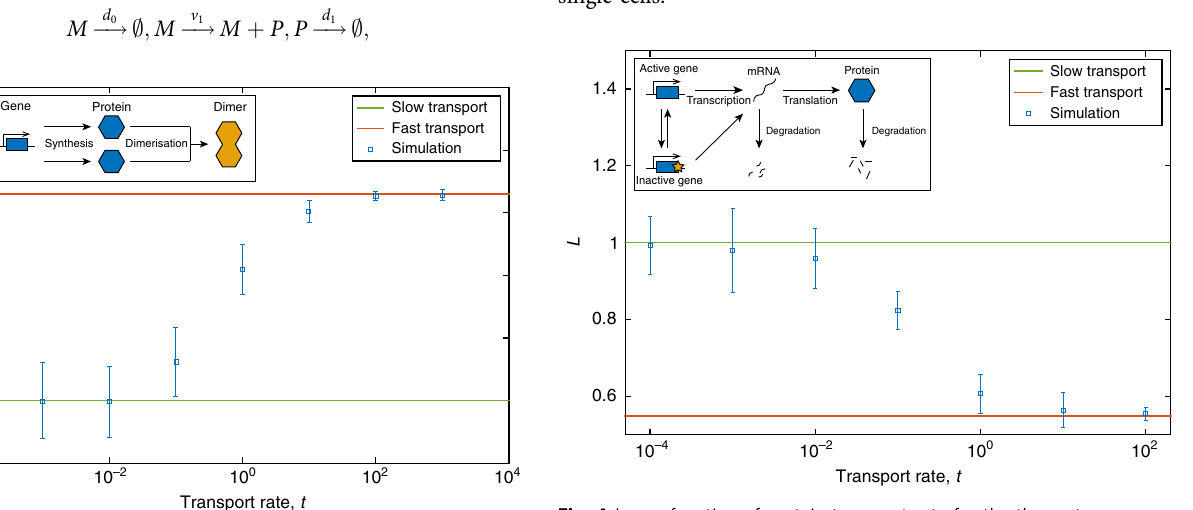
Fig. 3 L as a function of protein transport rate for the dimerisation system (3). Theoretical values for the fast transport limit (red) and slow transport limit (green) are shown as solid lines. Simulation data is shown for the average single-cell variability L (blue squares) for a variety of protein transport rates. Parameter values are k 1 = 32, k 2 = 0.01, V C = 1, V T = 100. Inset: schematic diagram of system (3)